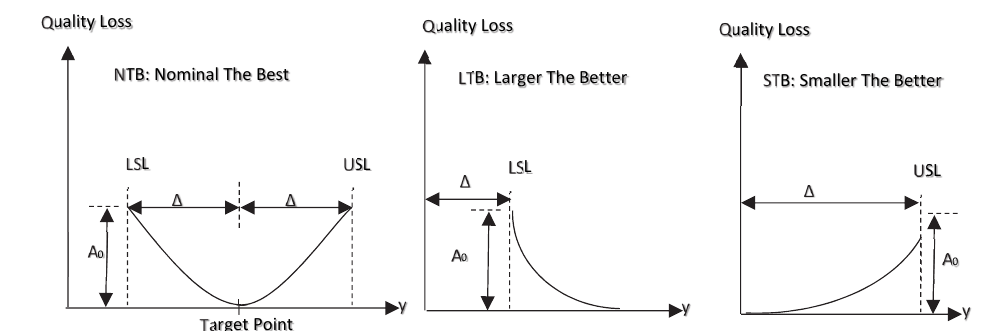
Fig. 5. Quality loss for three different types of quality characteristic, NTB, LTB,